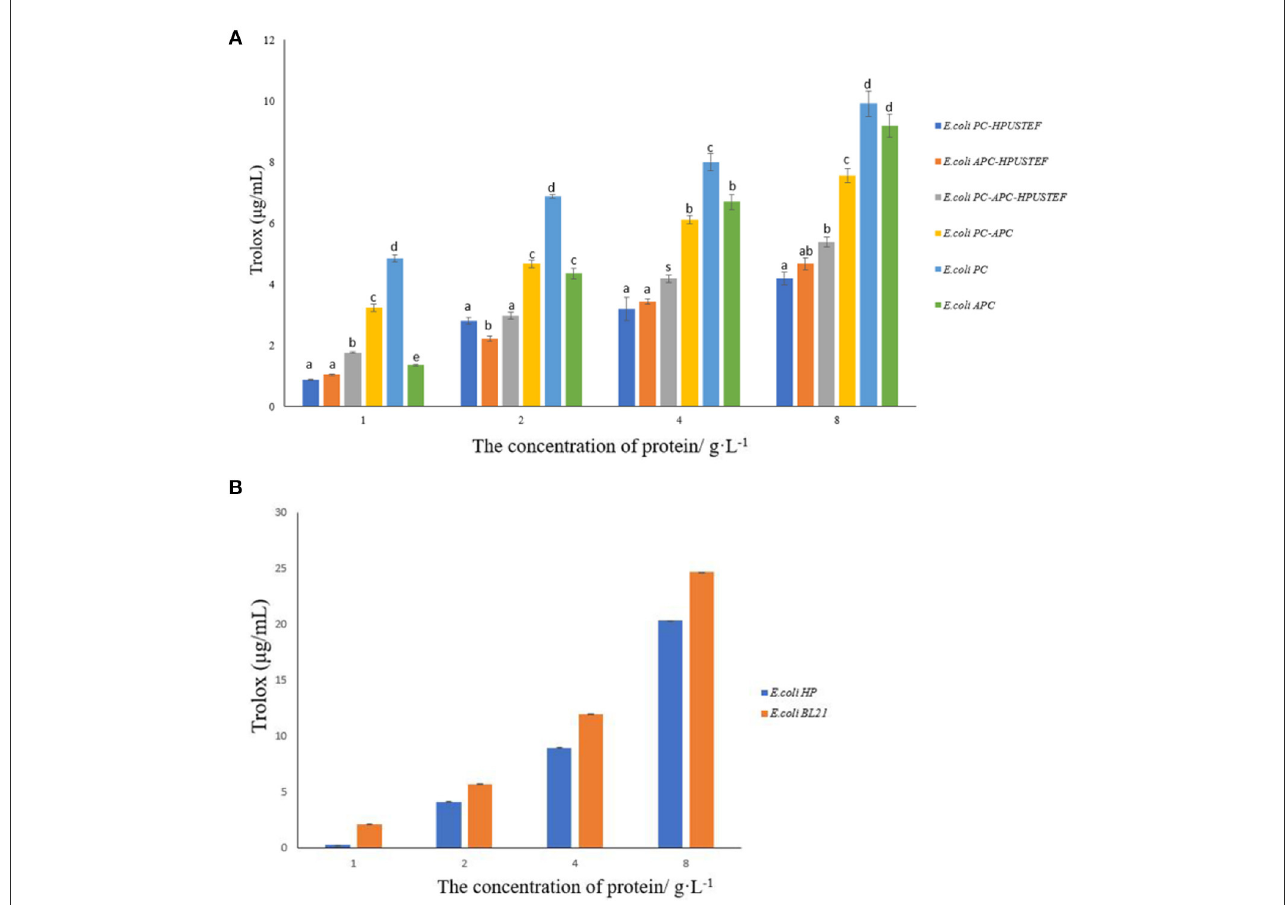
FIGURE7 DPPH free radical scavenging ability results. (A) Antioxidant capacity of purified recombinant protein samples; (B) antioxidant capacity of E. coli HP, E. coli BL21 unpurified samples.